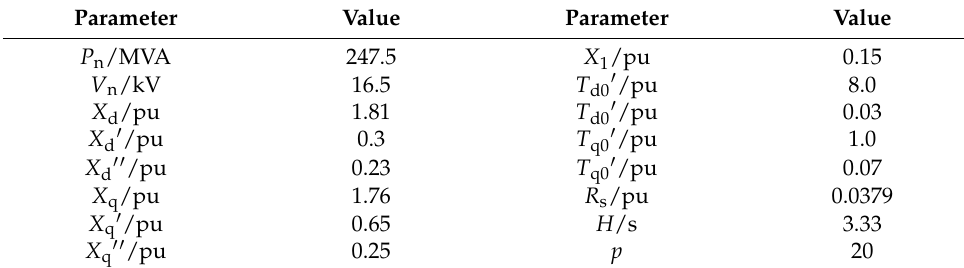
Table 2. Synchronous generator specific parameters.